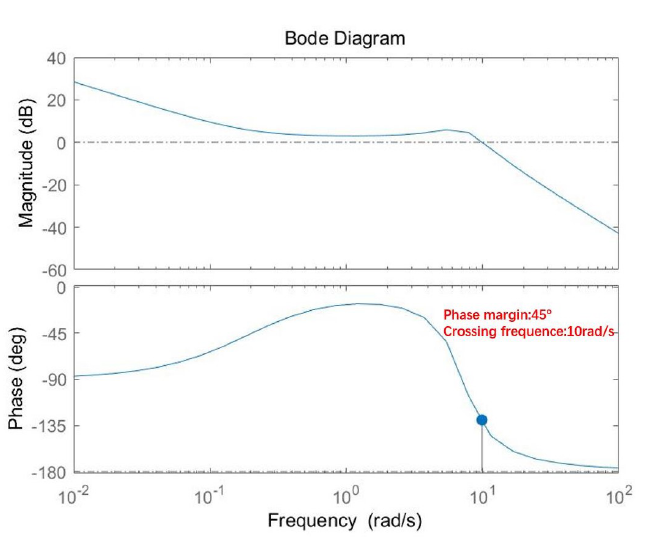
Figure 9. Open-loop frequency domain response of fractional order